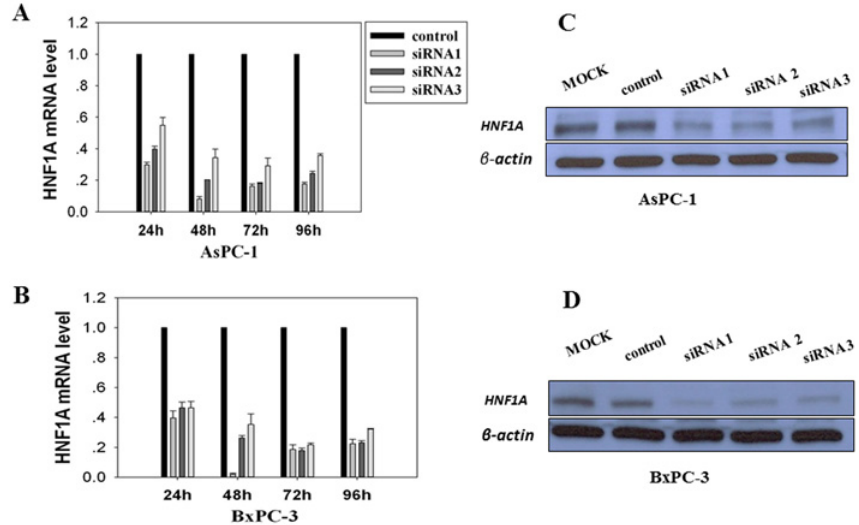
Fig 3. HNF1A knockdown by specific siRNAs in AsPC-1 (A) and BxPC-3 (B) cells. Cells were transfected independently with three different sequences of siRNA directed against HNF1A (siRNA1, siRNA2, siRNA3), or with a control siRNA (Control). Inhibition efficiencies were assessed by qPCR for relative levels of HNF1A mRNA at 24 h to 96 h following the transfections. Western Blot analyses of AsPC-1 and BxPC-3 cells transfected with anti-HNF1A siRNAs. Data are shown for 96 h following transfections. Expression of β -actin was used as an internal